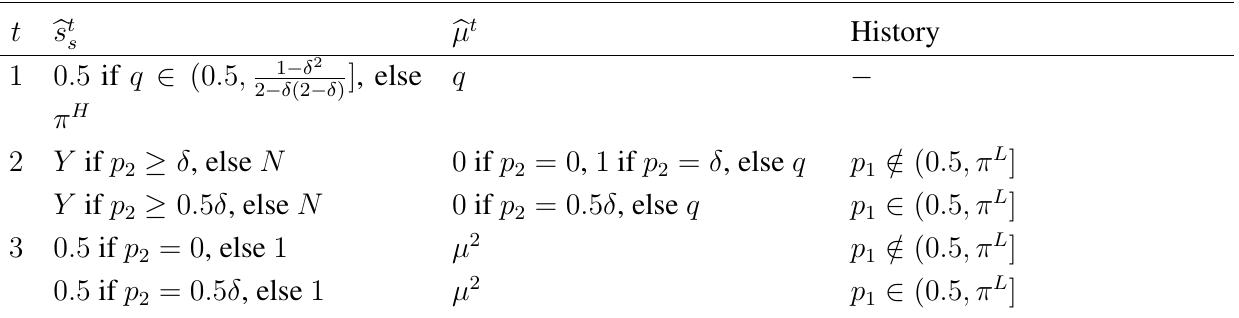
Table 3. Strategies and beliefs if q ∈ (0 . 5